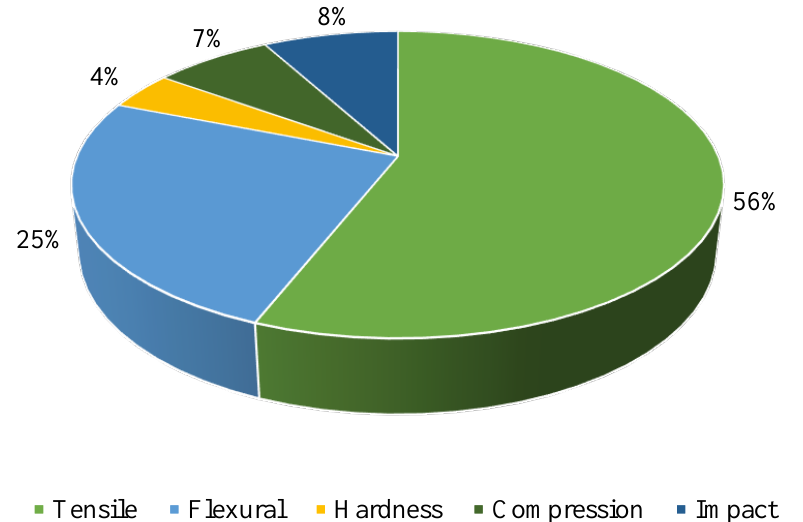
Figure 13. Mechanical properties that were studied primarily in the FDM process from the year 2011 to 2021.